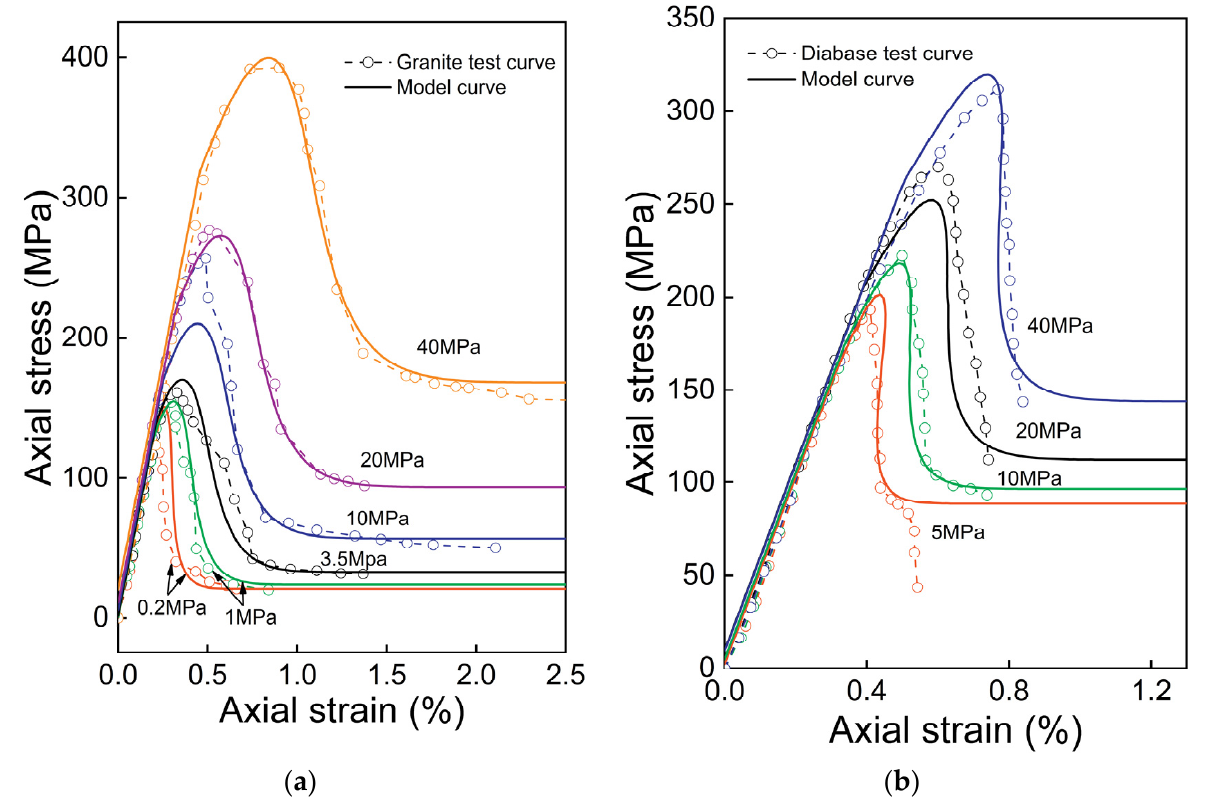
Figure 10. Comparison of the test curves and model curves: ( a ) Beishan granite [26]; ( b ) Danjiangkou diabase [37].